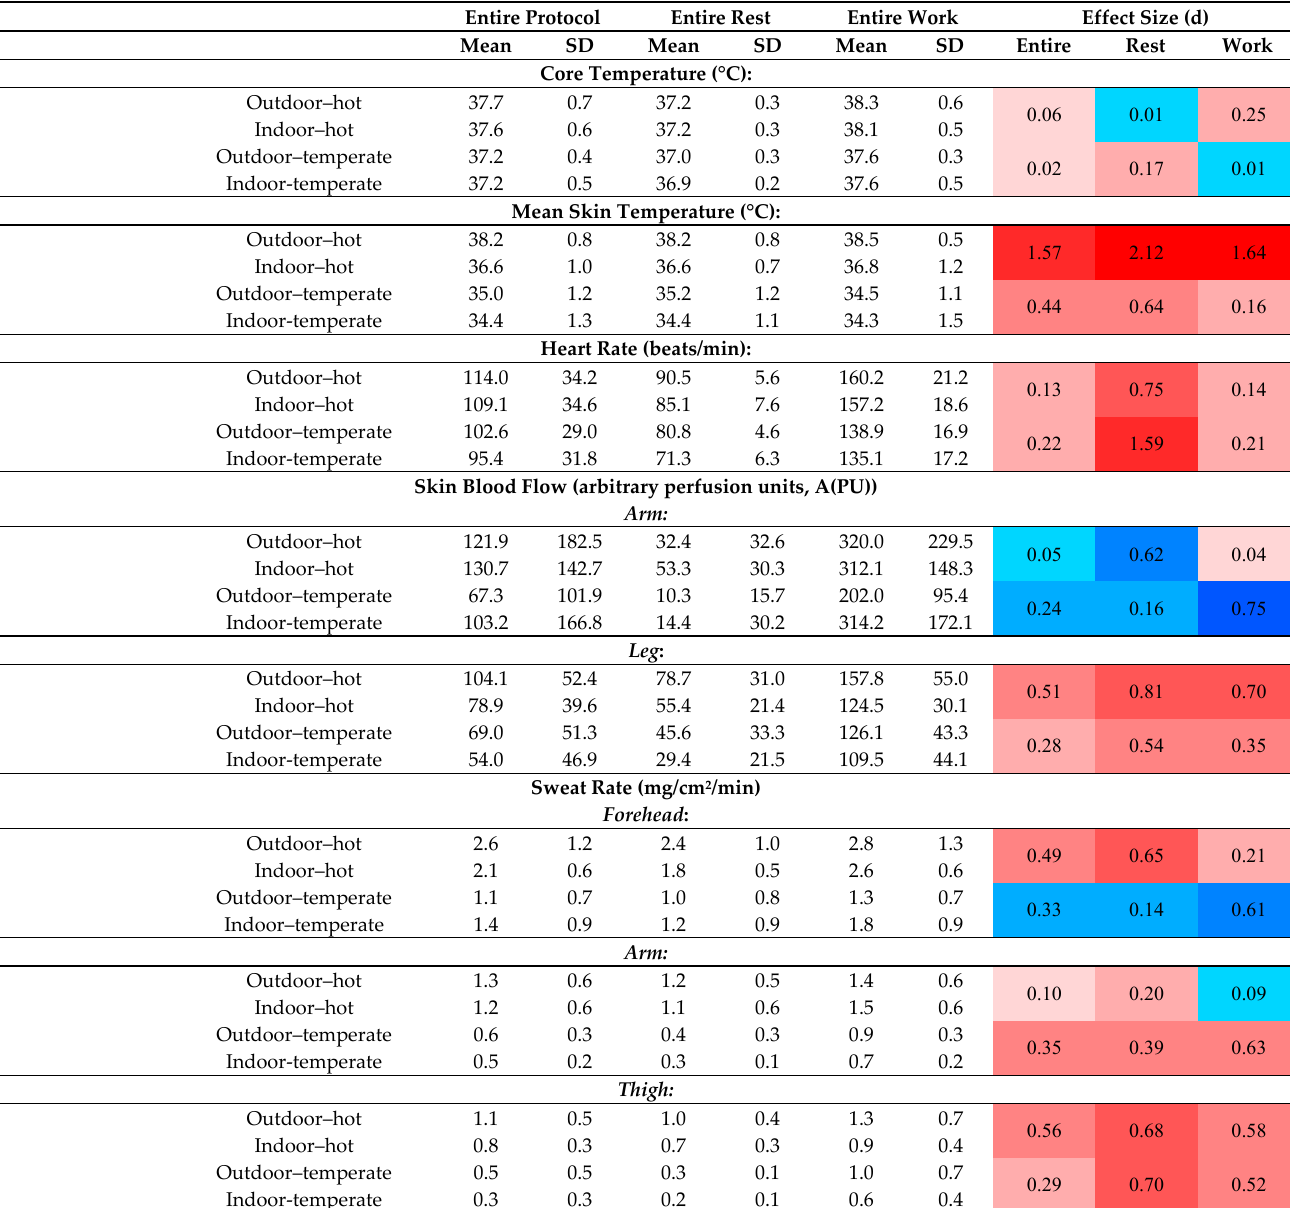
Table A5. The effect of solar radiation on physiological responses and cognitive performance.